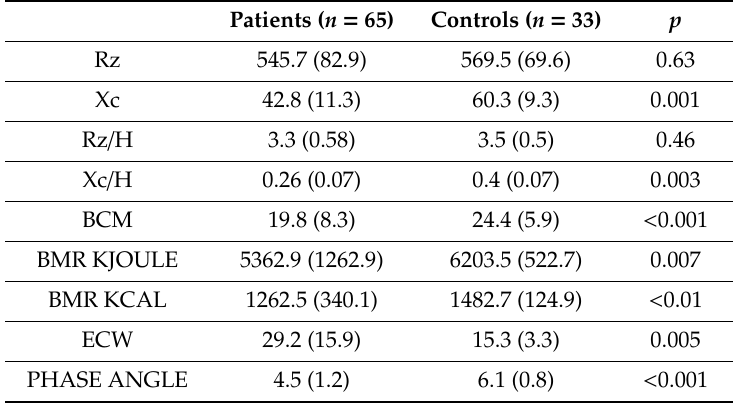
Table 3. Bioelectrical impedance analysis parameters of hemodialysis patients and heathy